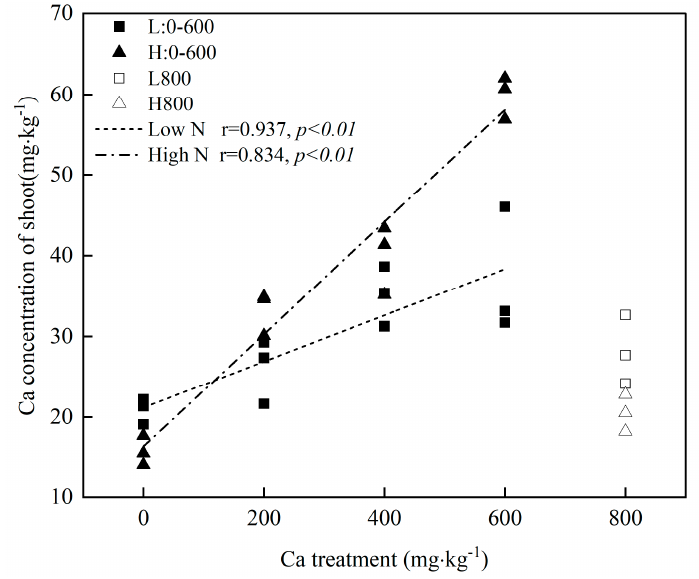
Figure 4. Relationship between Ca treatments and shoot Ca concentrations. L: 0–600 denotes the treatments of 0, 200, 400, and 600 mg · kg − 1 Ca under low N conditions; L:800 denotes the treatment of 800 mg · kg − 1 Ca under low N conditions; H:0-600 denotes the treatments of 0, 200, 400, and 600 mg · kg − 1 Ca under high N conditions; H:800 denotes the treatment of 800 mg · kg − 1 Ca under high N